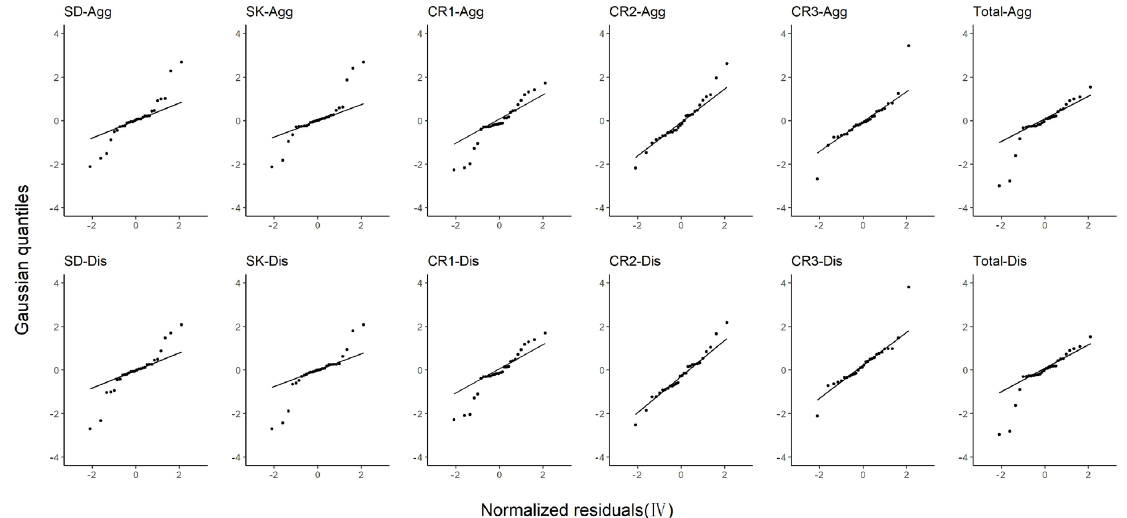
Figure 6. Gaussian probability plots of normalized residuals from the additive model and the disaggregated model for site class Ⅳ .